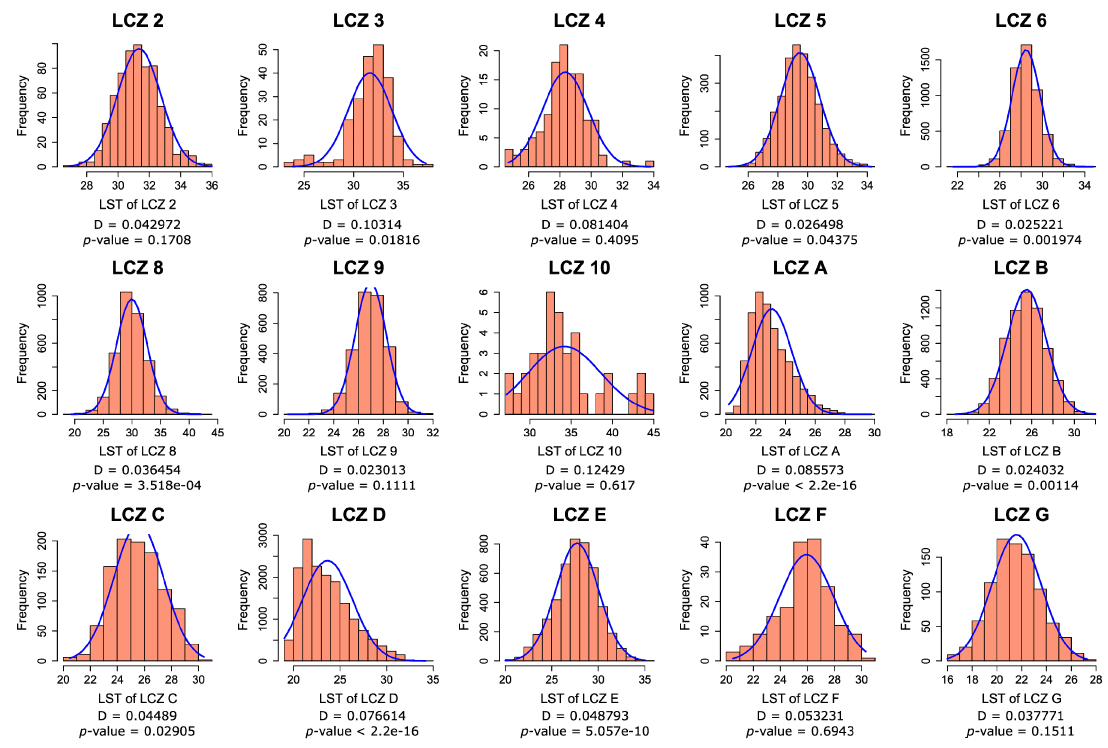
Figure 8. Frequency distribution of land-surface temperatures in LCZ classes completed with a fitted normal distribution and with the results of the Kolmogorov–Smirnov test. D stands for the testing criterion, and p is the corresponding p -value. A p -value less than 0.05 indicates departure from normality. The example features Prague, LANDSAT-8, 6 June 2015.